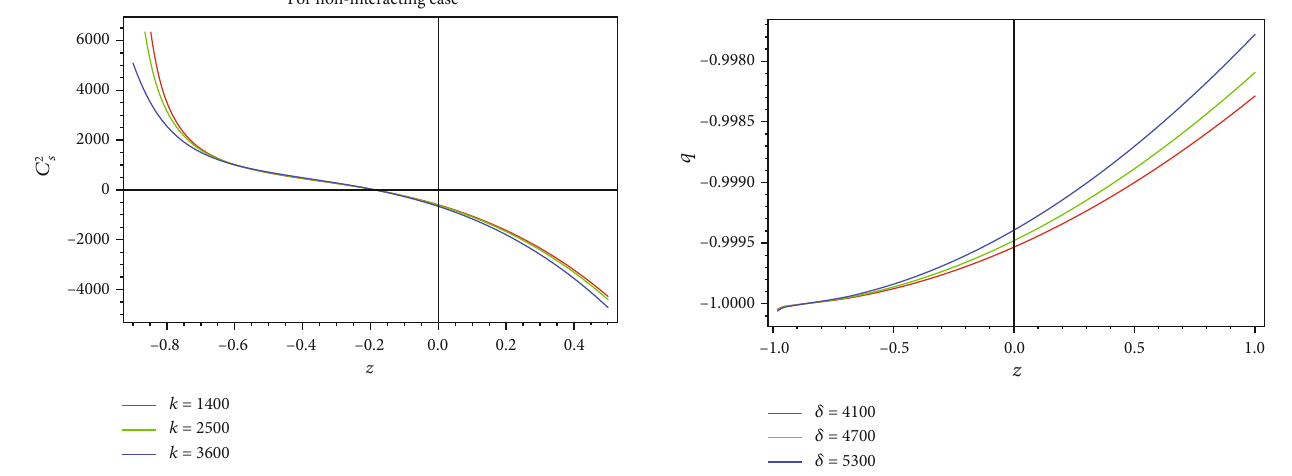
versus redshift s